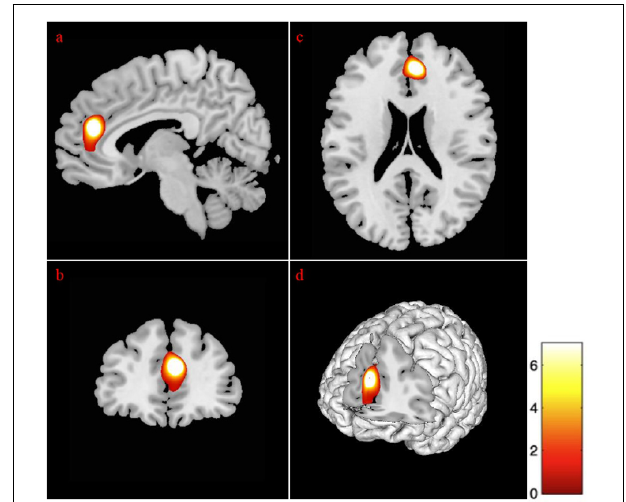
FIGURE 2 | Gender differences at gray matter regions. The position of the axes indicates more atrophy of the left temporal pole (MNI coordinates: − 34, 3, − 44) in old women than in old men, p = 0.001. The position of the axes indicates more atrophy of the left inferior temporal gyrus (MNI coordinates: − 36, 2, − 45) in young-old women than in young-old men, p = 0.001. (A) Sagittal plane, (B) coronal plane, (C) axial plane, and (D) 3D illustration, p =